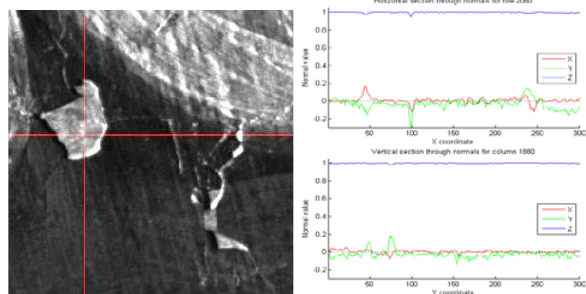
Figure 13. (left) Monochrome image of 300x300 pixel detail (same as Fig. 10), with locations of horizontal and vertical cross-sections shown by red lines; (right) normals along corresponding sections.